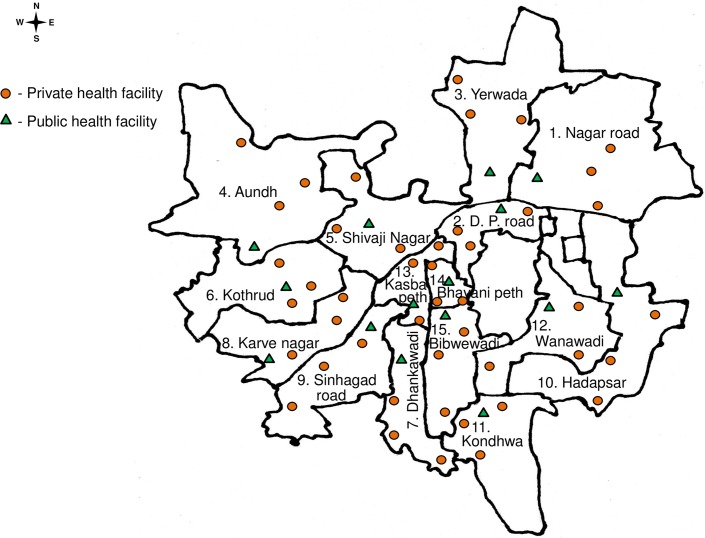
Geospatial distribution of the health facilities selected for conducting the sersurvey.Orange triangle symbol indicate PMC public health facility; round green symbols indicate private health facilities of general practitioners.